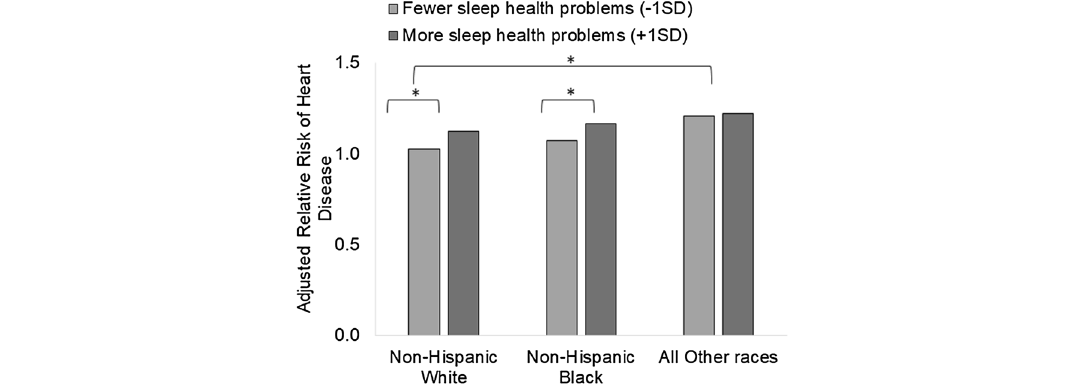
Figure 4. Moderation by race in the association between actigraphy/self-report sleep health composite and the risk of heart disease. Note. Compared to non-Hispanic Whites, those with all other races exhibited a weaker association between the actigraphy-self-report sleep health composite and the risk of heart disease ( B = − 5.83, SE = 1.77, 95% CI [− 9.30, − 2.37], P = .001). The slope for Non-Hispanic Whites was: B = 3.51, SE = 0.34, 95% CI [1.81, 6.81], P < .001. The slope for Non-Hispanic Blacks was: B = 1.93, SE = 0.27, 95% CI [1.93, 1.13], P = .016. The slope for all other races was: B = 1.06, SE = 0.62, 95% CI [0.31, 3.56], P = .930. There was no significant difference between non-Hispanic Blacks and non-Hispanic Whites ( B = − 0.60, SE = 0.42, 95% CI [− 1.42, 0.22], P = .151). The model adjusted for all